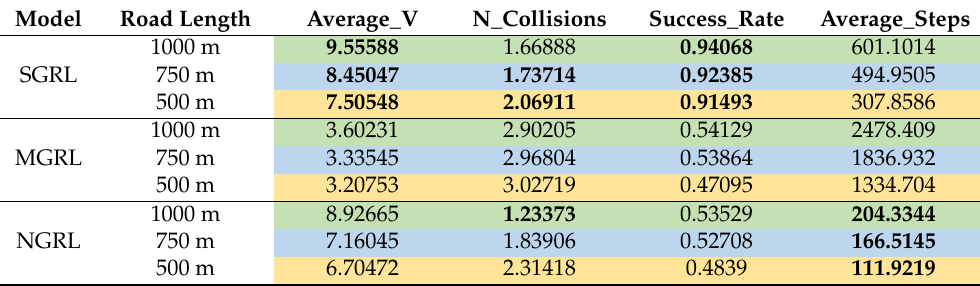
Table 5. Performance comparison for different